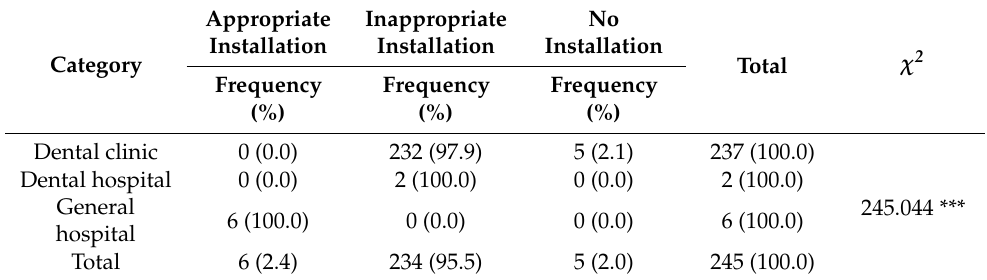
Table 7. Installation conditions of convenience facilities according to the type of medical